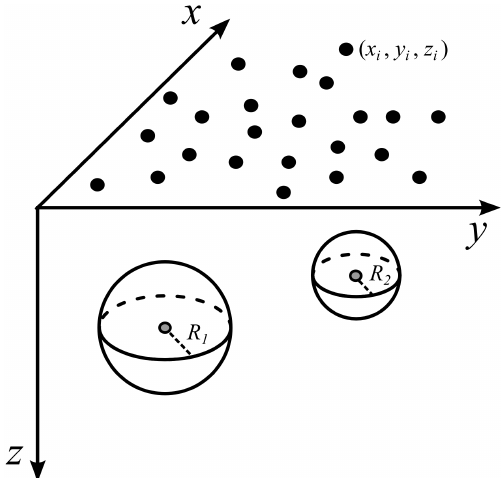
Figure 1. Schematic representation of L = 2 spheres uniformly magnetized at the subsurface. These spheres have radii R j (dashed straight lines), constant magnetization vectors m j and centres (grey dots) at ( xc j , yc j , zc j ), j = 1 ,...,L . The magnetic effect produced by these spheres can be observed at the points ( x i , y i , z i ), i = 1 ,...,N (black dots). In this Cartesian coordinate system, x points to the geographic north, y points east and z points